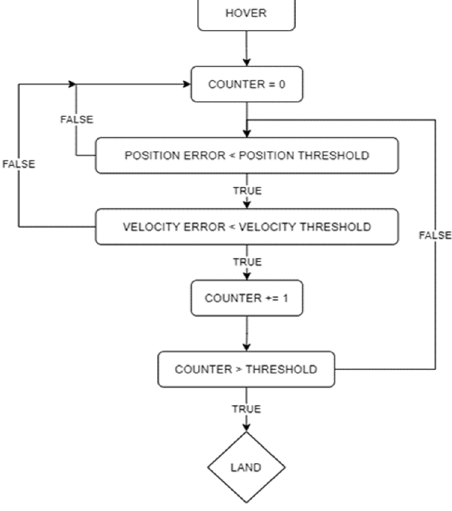
Figure 8. Autonomous landing loop flowchart.